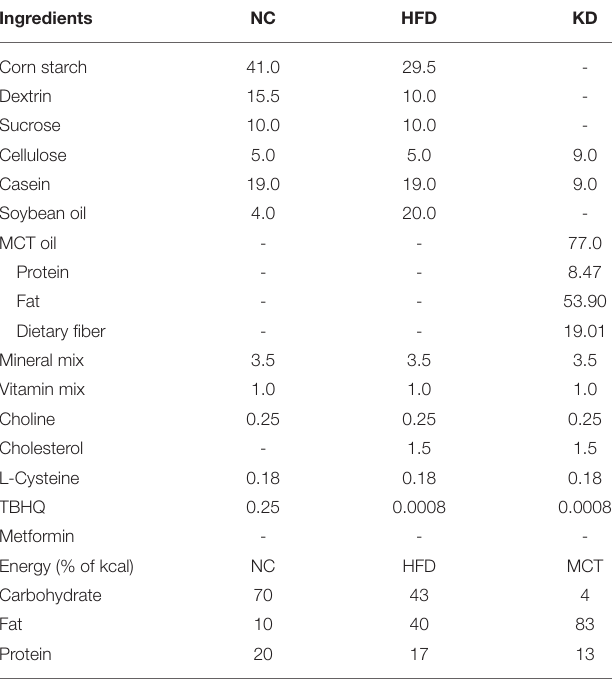
TABLE 1 | Composition of experimental